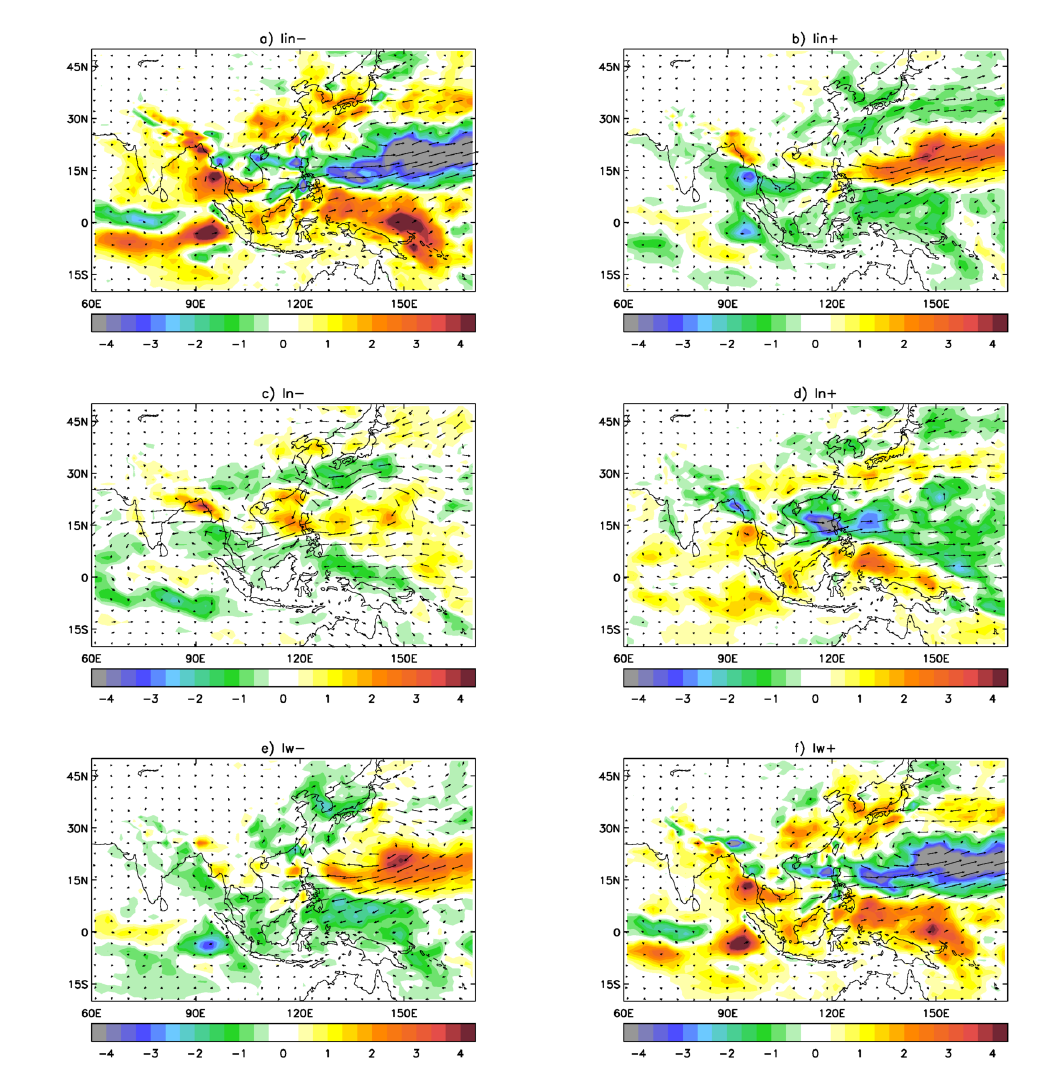
Figure 7. Same as Figure 6 but for control